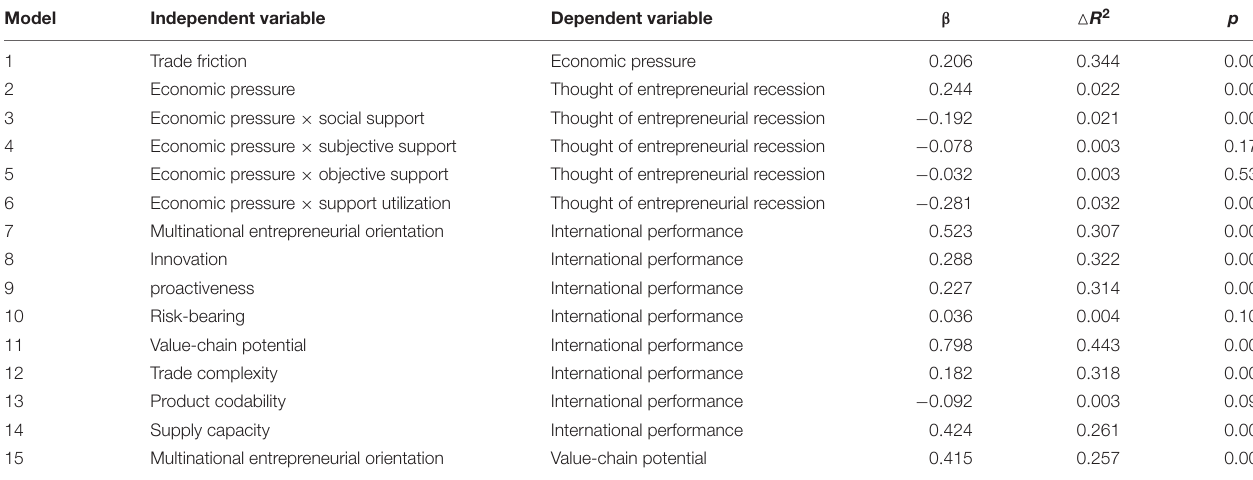
TABLE 7 | Analysis results of regression analysis models.